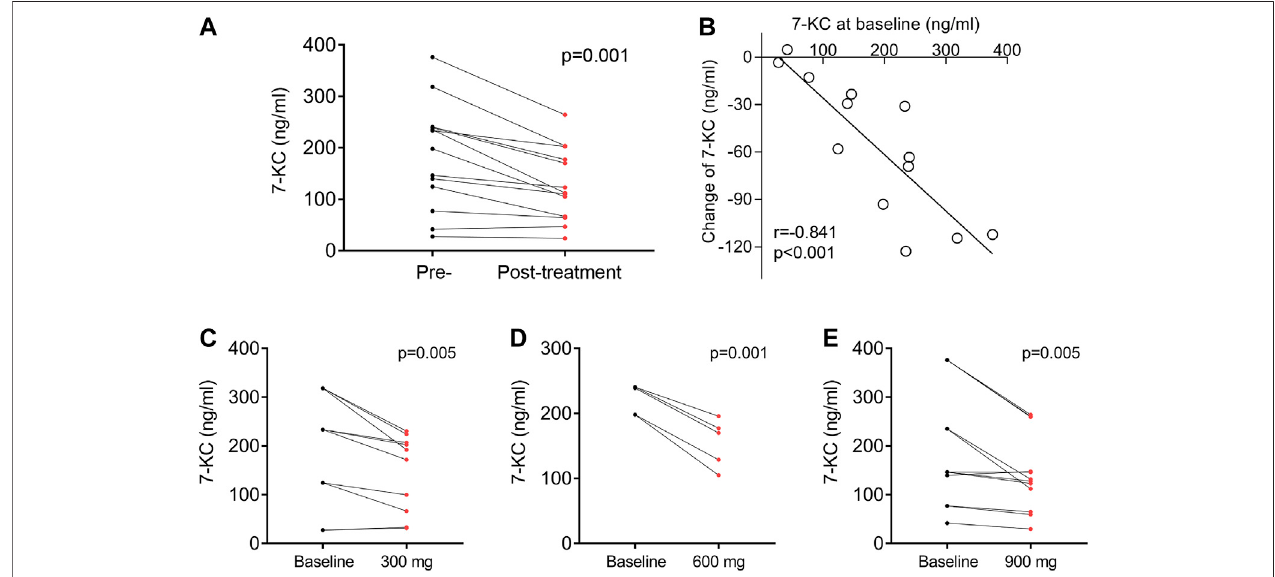
FIGURE 3 | Effect of lithium on 7-KC. (A) Plasma 7-KC concentration measured before and at the last follow-up after lithium administration in 13 patients. (B) The associationofplasma7-KCatbaselinewithchangesin7-KC.Concentrationchangeofplasma7-KCafteroraldosesof300 mg (C) ,600 mg (D) or900 mg (E) oflithium carbonate. Each paired set ofpre- and post-values represent an individual dose:10doses among four patients for300 mg, fi ve dosesamongthree patients for 600 mg and 12 doses among six patients for 900 mg r is the Pearson correlation coef fi cient.